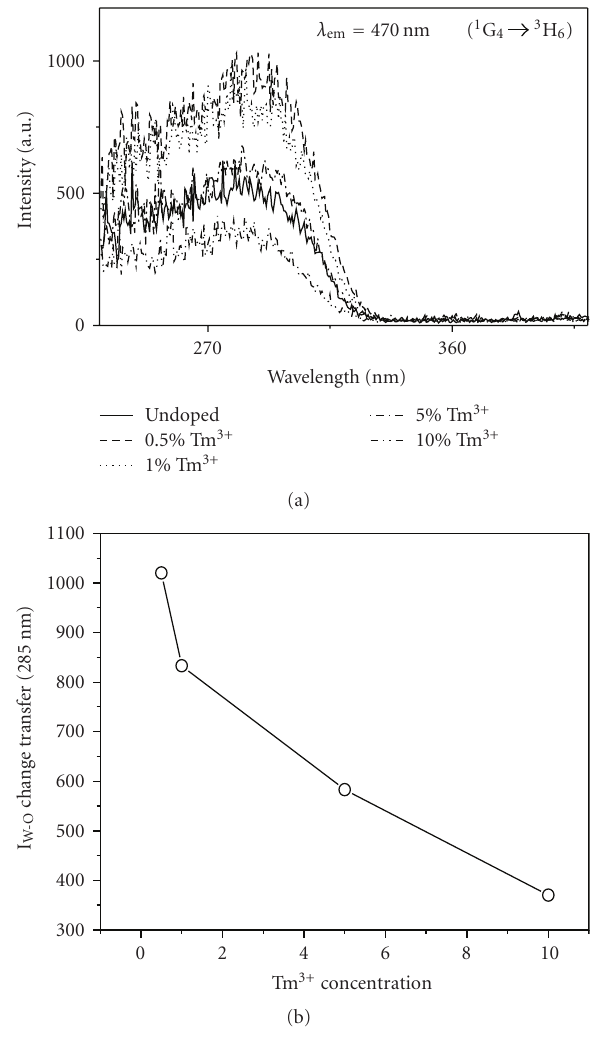
Figure 9: (a) Room temperature excitation spectra of LiIn 1 − x Tm x (WO 4 ) 2 , ( x = 0, 0.5, 1, and 5 at.%), monitoring 470 nm variation of their intensity against the Tm 3+ concentration, emission wavelength ( 1 G 4 → 3 H 6 transition) (b) W-O charge identical to the emission spectra (see Figure 6(a)). Based on transfer excitation band intensity monitoring 470nm emission the energy scheme of Tm 3+ , we have assigned this peak to the ( 1 G 4 → 3 H 6 transition) as a function of Tm 3+ concentration. 3 H → 1 D 6 2 excitation transition. The intense band around 285 nm should be assigned to the W-O ligand-to-metal charge transfer states (LMCT) from (WO 6 ) units in the host lattice. LiIn(WO 4 ) With increasing Tm 3+ concentration, the narrow peak 2 Room temperature emission spectra of intensity decreases with the increasing from 0.5 to 10 ( x = 0, 0.5, 5, and 10 at.%), under LiIn 1 − x Tm x (WO 4 ) at.% (Figure 8(b)) due to the concentration quenching. 2 the excitation wavelength of 285 nm (corresponding to the The intensity of broad-band decreases also with Tm 3+ W-O ligand-to-metal charge transfer) between 400 and concentration in full studied concentration region, which 600 nm, are shown on the Figure 8(a). There are two kinds implies that the energy transfer from (WO 4 ) − 2 to Tm 3+ of emission for all doped phosphors observed, a narrow increases. We believe that the optimum of compositions with peak at 470 nm originates from the Tm 3+ ion transition the highest emission intensity for 1 G 4 → 3 H 6 is lower than 1 G → 3 H 0.5 at.%. 4 6 , and a broad-band centred around on 450 nm. This broad emission band is ascribed to the radiative decay On Figure 9(a), the excitation spectra of of the regular lattice centre (WO 4 ) − 2 or radiative decay of ( x = 0, 0.5, 5, and 10 at.%), recorded at LiIn 1 − x Tm x (WO 4 ) 2 room temperature in the 230–410 nm region, for 470 nm excitons self-trapped (localized) on regular (WO 4 ) − 2 groups. Tungstate complexes are usually characterized by a broad emission wavelength ( 1 G 2 → 3 H 4 transition) are displayed. For all samples the excitation spectra show only a wide band emission with large Stokes shift (10000 cm − 1 (1.24 eV) to − 20000 cm − 1 (2.28 eV)) from the absorption [28]. and intense band centered on 285 (W-O